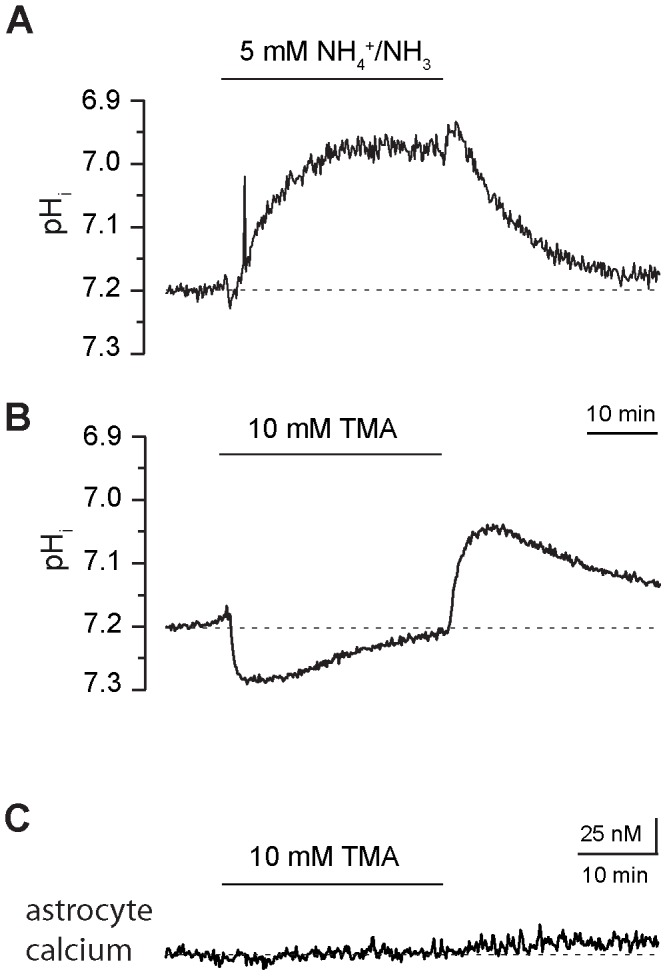
Interrelationship between NH4
+-induced changes in calcium and pH.
(A) Changes in intracellular pH (pHi) evoked by bath perfusion with 5 mM NH4
+/NH3 for 30 minutes (indicated by bar) in a SR101-positive hippocampal astrocyte. (B) Changes in a hippocampal astrocyte evoked by perfusion with the weak base trimethylamine (TMA, 10 mM) for 30 minutes (indicated by bar). Note the pronounced alkalinization, which is followed by an acidification upon removal of TMA. (C) Trace showing intracellular calcium in a hippocampal astrocyte and the influence of perfusion with TMA (10 mM). Note that TMA does not evoke any changes in astrocyte calcium.